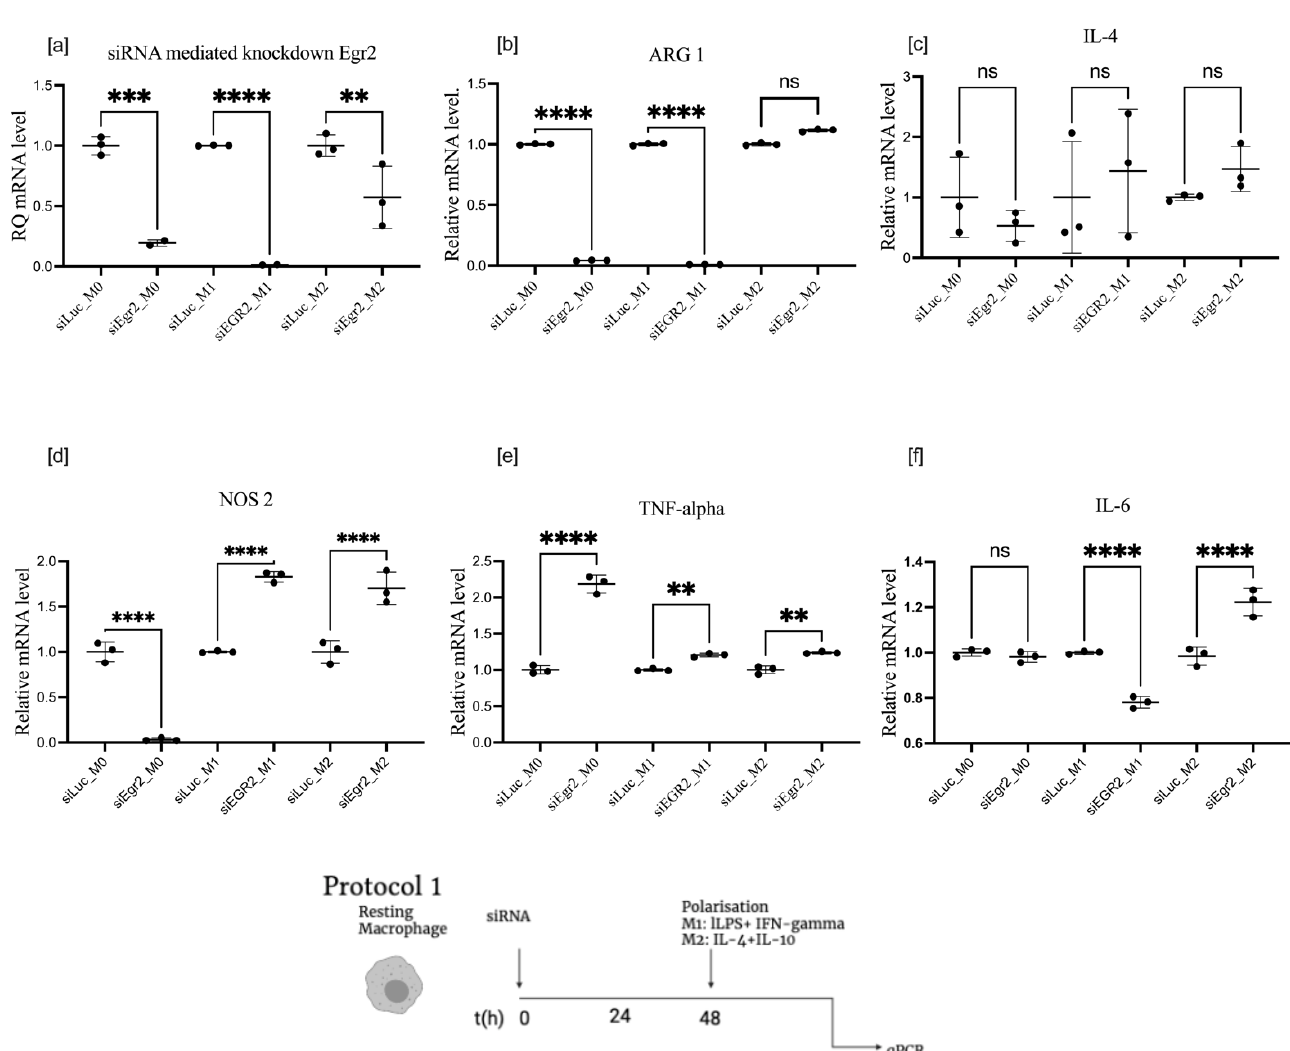
Figure 3. mRNA expression of EGR2 ( a ), ARG1 ( b ), IL-4 ( c ), NOS2 ( d ), TNF- α ( e ), and IL-6 ( f ) after EGR2 knockdown in post-transfected polarized BMDMs, treated according to protocol 1. Data are presented as mean SD, n = 3 [ns; not significant;** p < 0.01; *** p < 0.001; **** p < 0.0001].